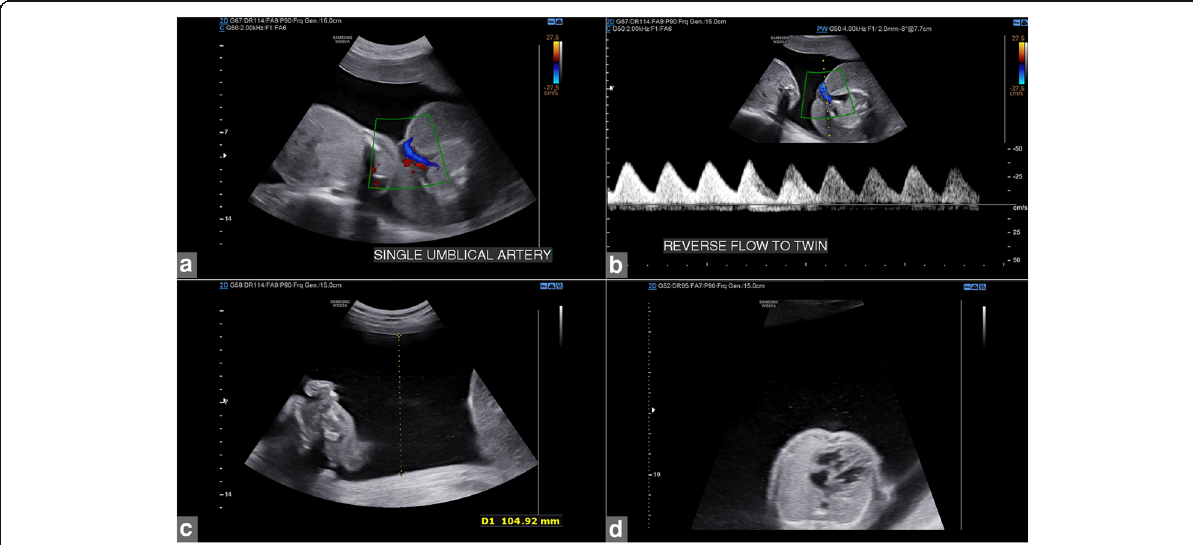
Fig. 3 Single umbilical artery ( a ) with reversed flow to the acardiac fetus at pulsed Doppler study ( b ). Polyhydramnios ( c ) and mild cardiomegaly ( d ) in pump twin are signs of altered fetal heart